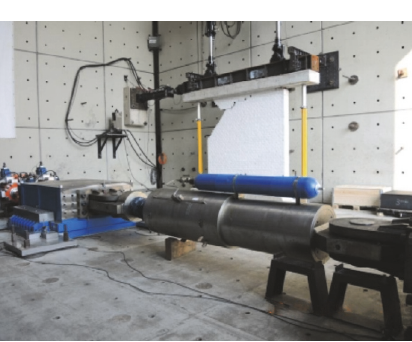
Figure 8: Installation for testing.